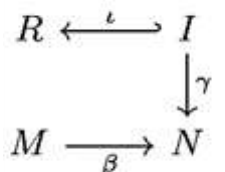
Diagram 12: Homomorphic image of the N injective